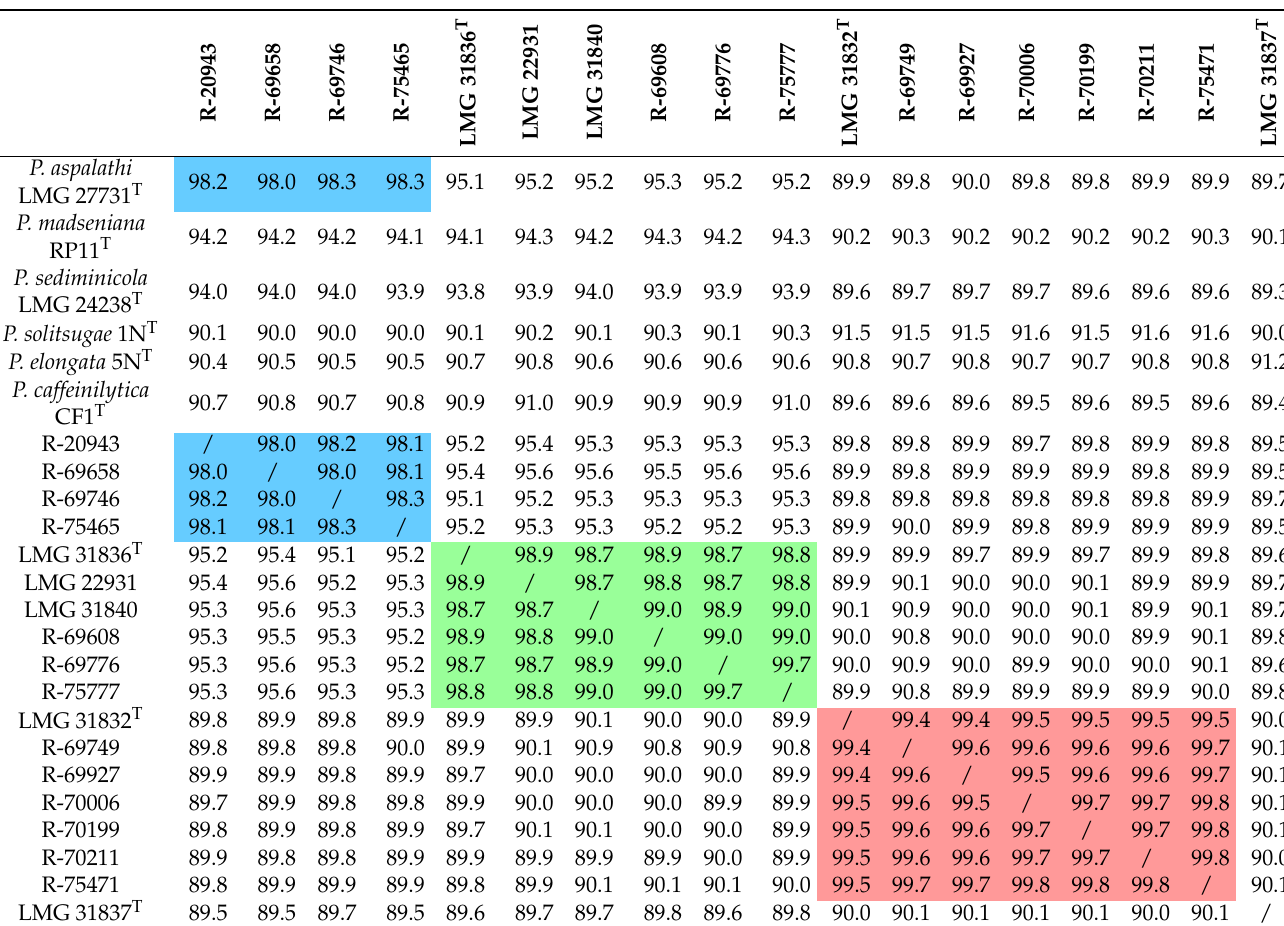
RP11 T . These high similarity values confirmed that the 16S rRNA gene lacks resolution among closely related Paraburkholderia species. Table 3. Pairwise orthoANIu (%) values between strains of the present study and their closest phylogenetic relatives. Values of 96% or higher were highlighted in color according to their respective clusters (Figure 2); A, blue; B, green; C,